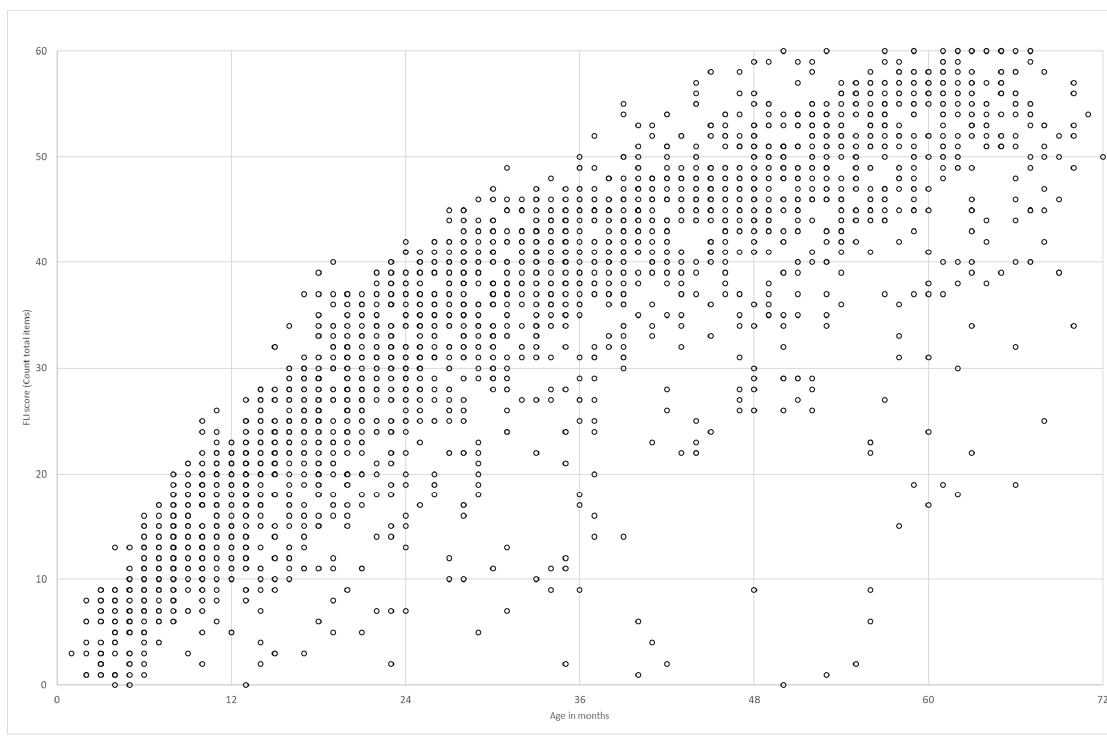
Figure 1. Early Intervention (EI) group total FLI-P data points. FLI-P scores collected from all chil- dren enrolled in the program over the course of the study. Each point may represent more than